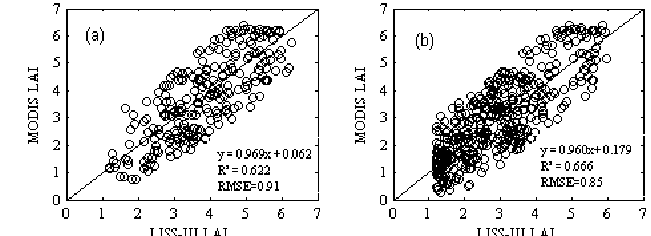
Figure 4. Inter comparison of IRS-LISS-III derived LAI with MODIS LAI product in KNP over (a) Sal forest and (b) mixed forest during